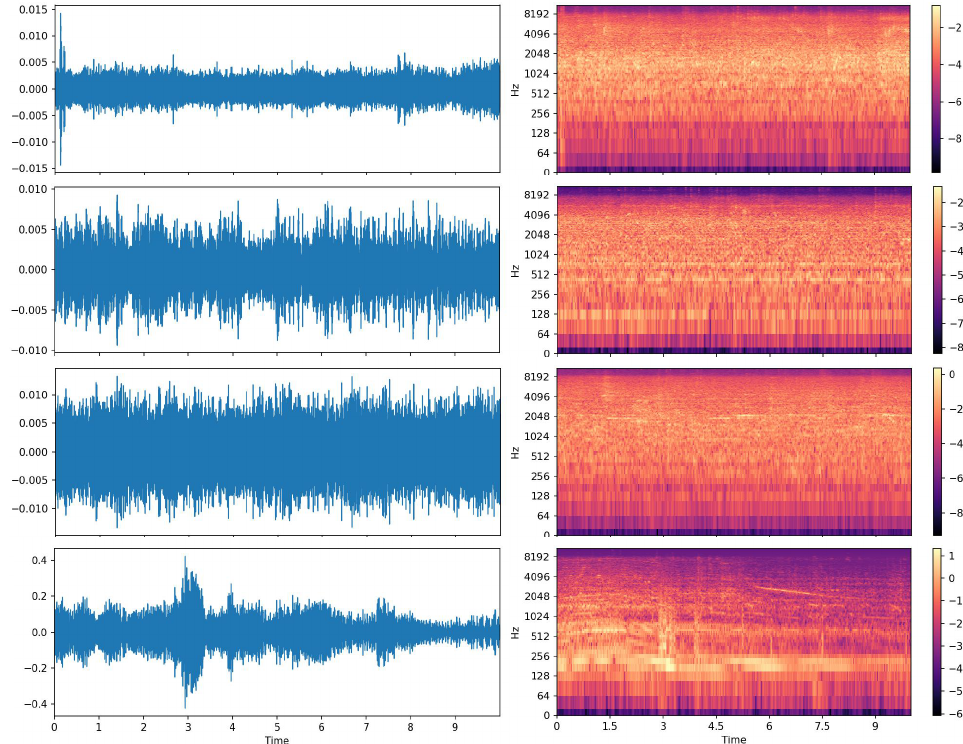
Figure 11. The 10-s audio clips from DCASE’18 ASC [30]. Left : the raw waveform data. Right : the corresponding log Mel spectrogram. The acoustic scenes from top to down: airport, park, shopping